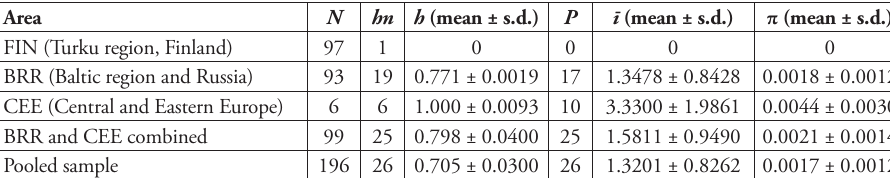
Figure 2. Minimum spanning networks presenting 26 haplotypes in O. barnabita . The size of each circle corresponds to its relative frequency in the total sample. The number in each circle offers a unique identifier for each haplotype (H1-H26). Haplotype samples collected from the Baltic region and Russia (BRR: Estonia, N = 1, H5; Latvia, N = 89, H5, H10-26; Russia, N = 3, H5, H8) are coloured in orange, from Central and Eastern Europe (CEE: Croatia, N = 1, H1; Germany, N = 1, H2; Hungary, N = 2, H6, H7; Slovakia, N = 1, H3; Romania, N = 1, H9) in light green and Finnish samples from the Turku region (FIN, H4: Artukainen, N = 3; Jänessaari, N = 4; Muhkuri, N = 7; Pansio, N = 1; Ruissalo, N = 81; Runeberg Park, N = 1) in dark blue, with haplotype numbers in white. Smaller black dots on lines between individual haplotypes indicate the number of mutation steps separating Table 2. Mitochondrial DNA CO1 sequences variation in Osmoderma barnabita . Estimates of genetic diversity amongst regions, with the following metrics identified: N = regional sample size (number of individuals), hn = number of distinct haplotypes, h = haplotype diversity, P = polymorphic sites, ī = mean pairwise genetic differences (uncorrected p distances), π= nucleotide diversity. Calculations are based on a sequence length of 759 bp. Area N hn h (mean ± s.d.) P ī (mean ± s.d.)